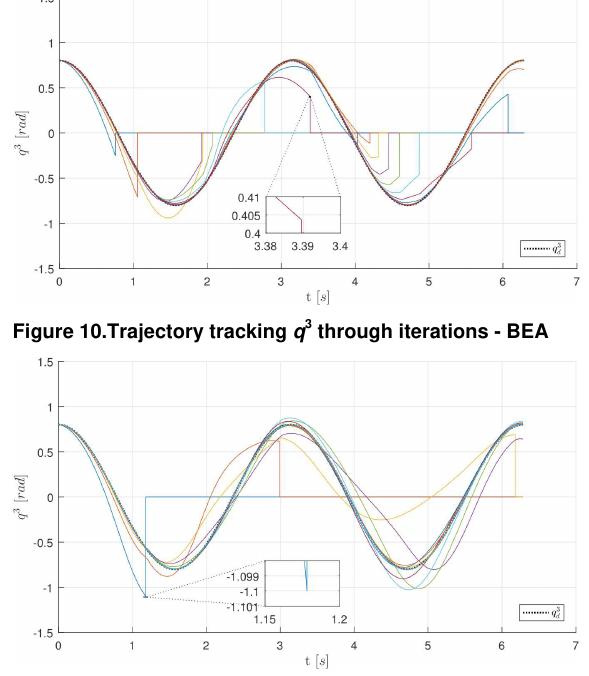
Figure 9. Iteration duration time